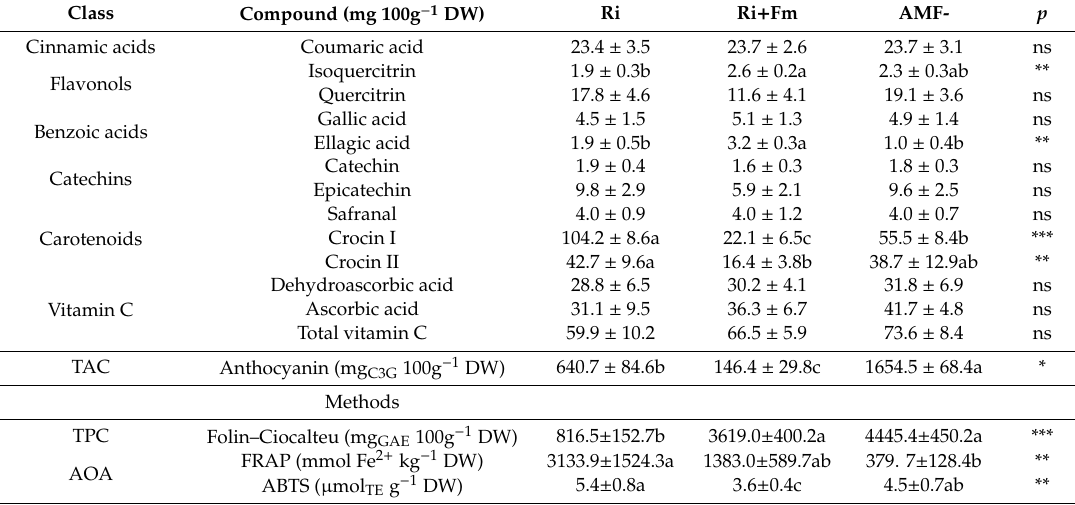
Table 3. Bioactive compounds, anthocyanins, total polyphenol content and antioxidant activity (ferric reducing antioxidant power (FRAP) and 2,2 (cid:48) -azinobis(3-ethylbenzothiazoline-6-sulfonic acid) (ABTS); antioxidant activity (AOA)) of the sa ff ron produced via glasshouse cultivation with AMF inocula composed of Rhizophagus intraradices alone (Ri), R. intraradices and Funneliformis mosseae (Ri + Fm) or a control